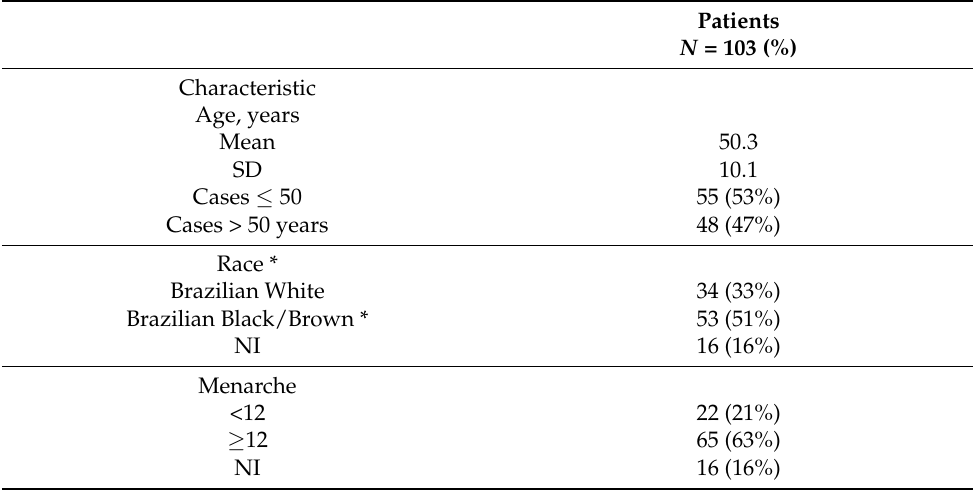
Table 1. Patient and tumor